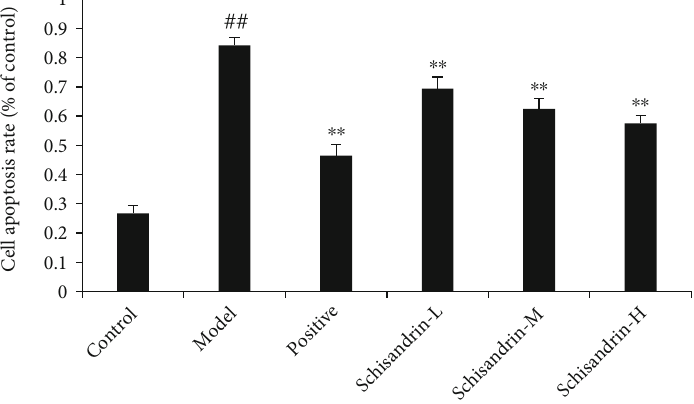
Figure 4: E ff ects of di ff erent concentrations of Schisandrin on CORT-induced apoptosis rate. Cells were induced with CORT (250 μ mol/L) for 24 h and subsequently treated with Schisandrin (0.1, 1, and 10 μ mol/L) or CORT (250 μ mol/L) for 24h. ## p < 0 : 01 , compared with the control group; ∗∗ p < 0 : 01 , compared with the model group.